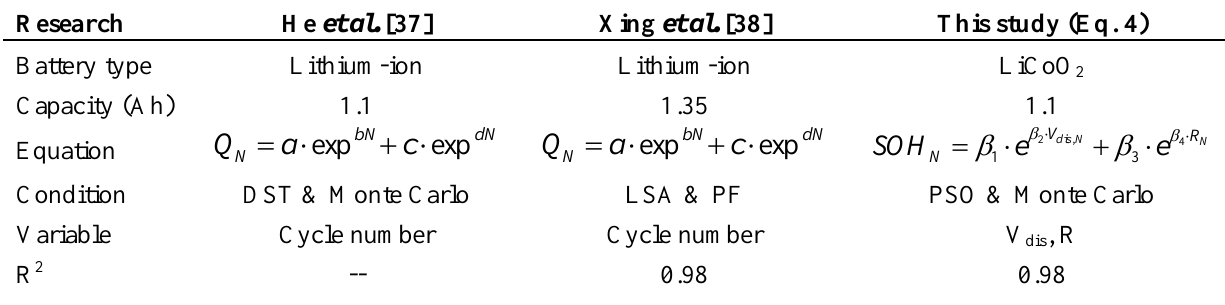
Table 4. Comparison of the results of exponential